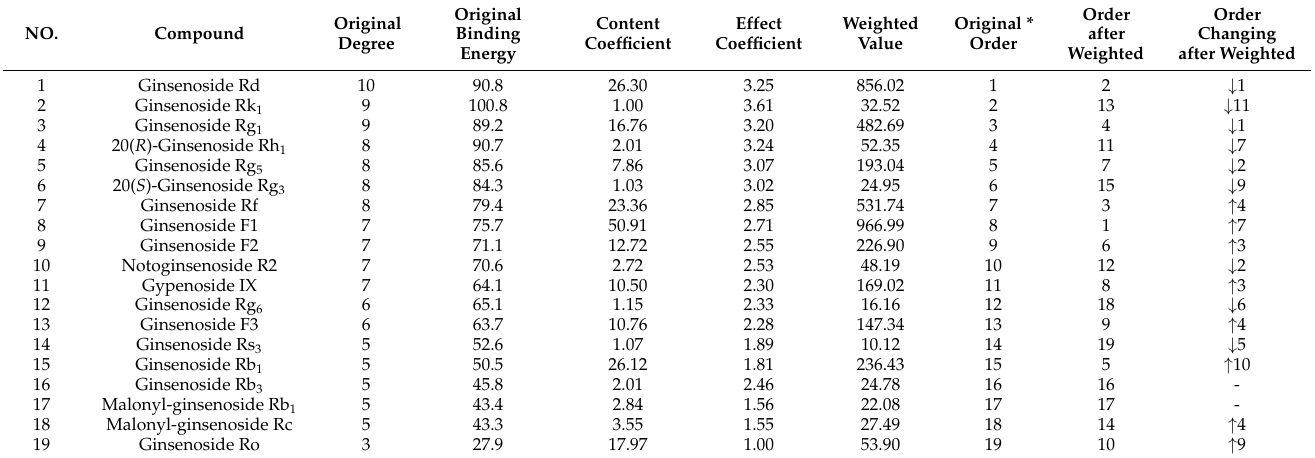
Table 2. Weighted values of nineteen ginsenosides using the Content-Effect weighted method.